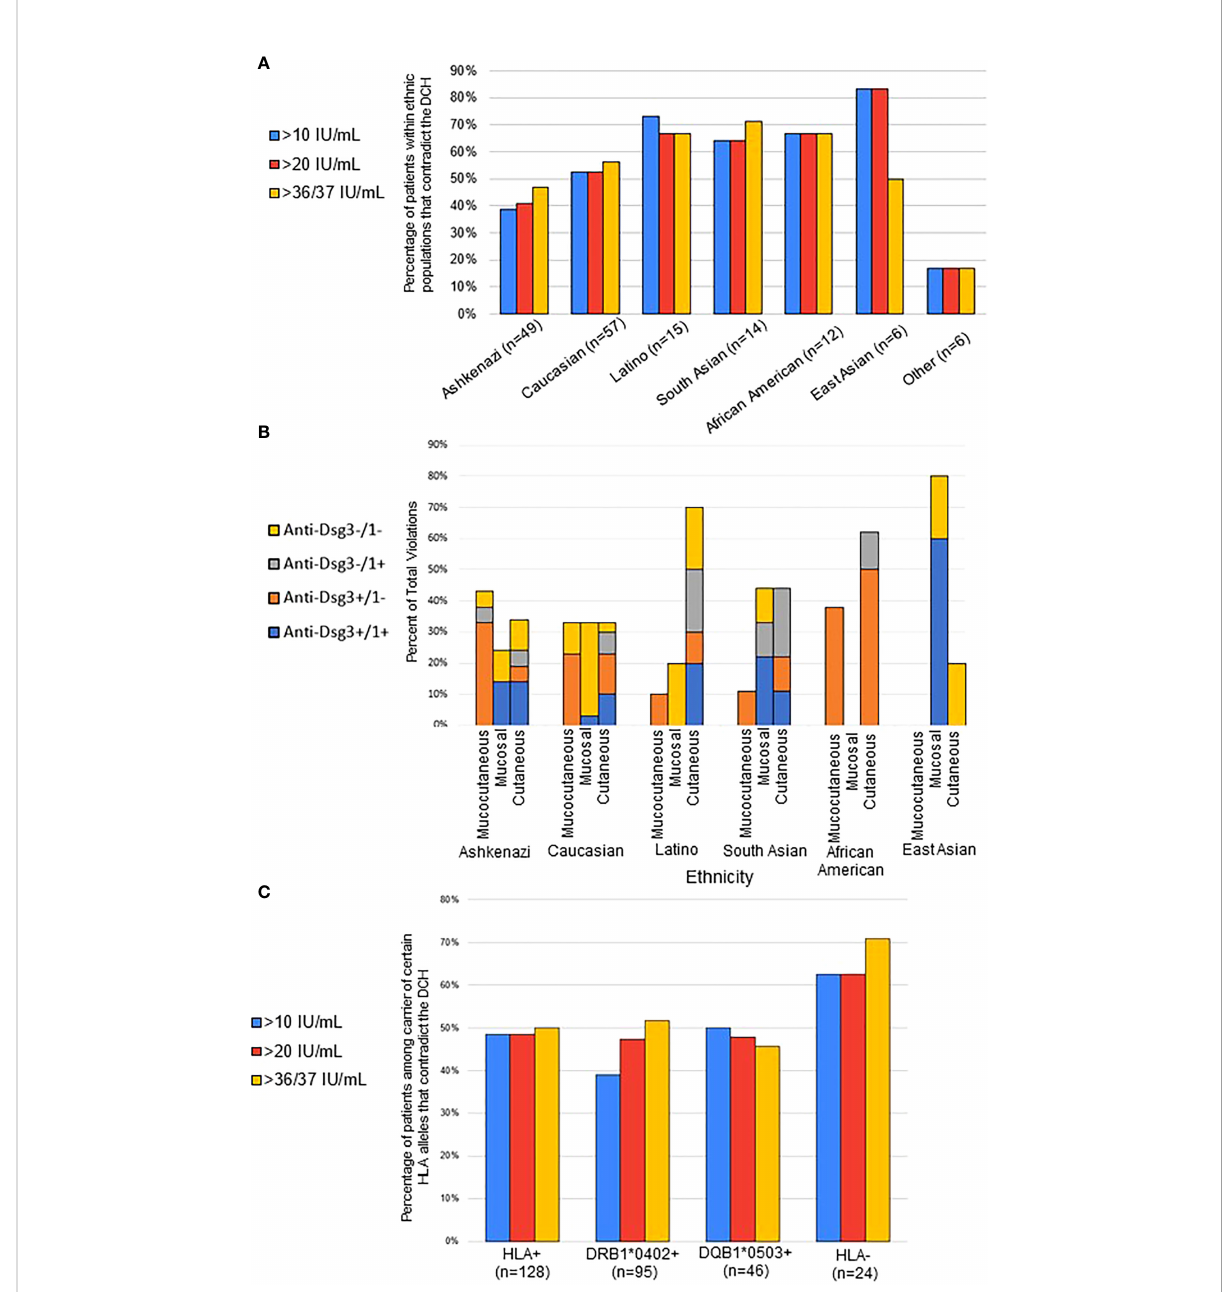
FIGURE 2 Contradictions to the DCH differ by ethnicity and HLA association. (A) For each ethnicity, the proportion of conformity and contradiction to the DCH was determined based on their lesion phenotype and anti-Dsg3/1 positivity for each visit. The percentage of contradiction is presented using the 10-, 20-, and 37/36 IU/mL anti-Dsg cutoff, with similar percentages seen in all cutoffs. The Ashkenazi Jewish population had a noticeably smaller proportion of subjects that contradicted the DCH compared to those of Caucasian, South Asian, African American, Latino, and East Asian ethnicities (p=0.09). (B) Within each ethnic group, the type of violation of the DHC was broken down into speci fi c lesion morphology and associated anti-Dsg pro fi le. Results are presented as percent of violation within the speci fi c ethnic group. (C) Subjects were considered “ HLA-positive ” (HLA + ) if they carried either of or both the previously described PV-associated susceptibility HLA alleles DRB1*0402 and/or DQB1*0503. All active PV patients were classi fi ed as either HLA + , only DQB1*0402-positive, only DQB1*0503-positive, or negative for either allele (HLA - ). We found that 48.44% (n = 128) of those that are HLA+ contradict, 47.37% (n = 95) that are DRB0402 + contradict, 47.83% (n = 46) that are DQB0503 + contradict, and 62.50% (n = 24) that are HLA - for PV alleles contradict (p=0.06 when using chi-square with the anti-Dsg3/1 cutoffs of 37 and 36